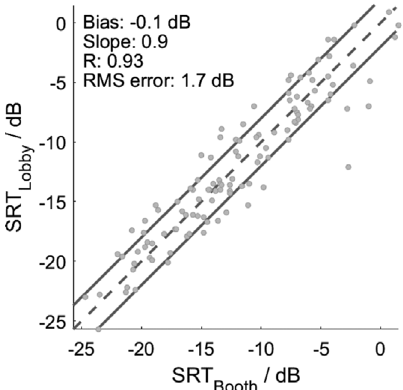
Figure 7. Comparison of SRTs measured in the lobby and the booth for each condition (unprocessed, IBM, BMVDR-N) and each subject. Solid lines represent a corridor of ±2 dB around the intersection.